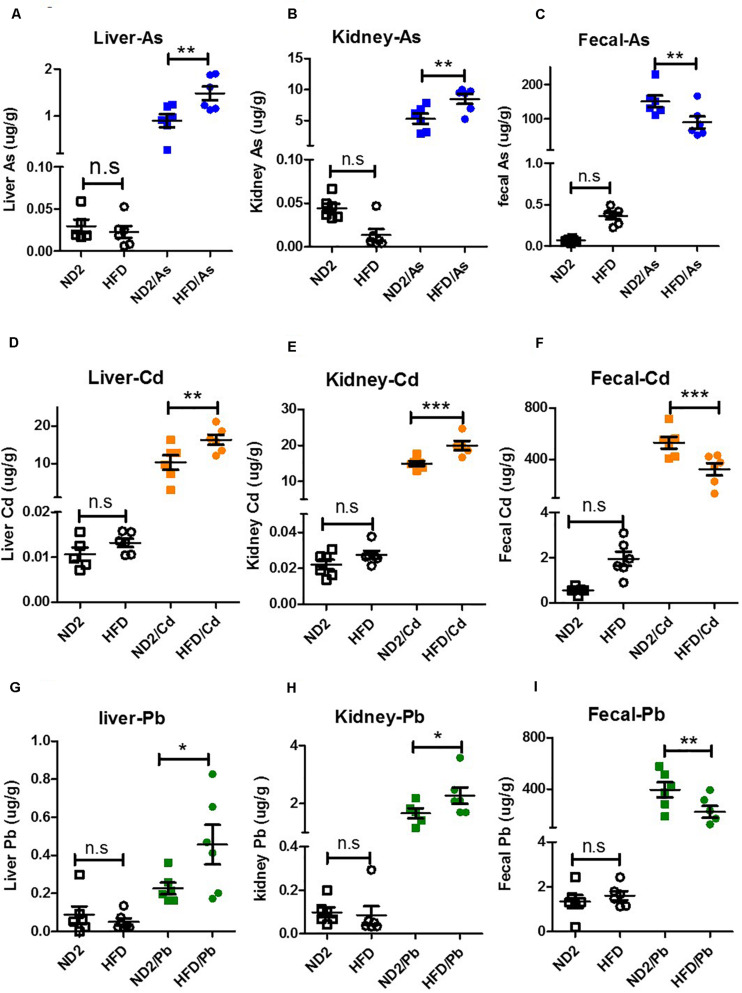
Diet effects on heavy metal accumulation in the liver and kidney and elimination in feces. ND- and HFD-fed mice were exposed to 100 ppm As, Cd, or Pd for 10 weeks (n = 6 for each group). Feces, liver, and kidney were collected for As, Cd, or Pb content analysis. (A,B) Bioaccumulation of As in the liver/kidney of ND- and HFD-fed mice upon As exposure. (C) As content in feces of ND- and HFD-fed mice upon As exposure. (D,E) Bioaccumulation of Cd in the liver/kidney of ND- and HFD-fed mice upon Cd exposure. (F) Cd content in feces of ND- and HFD-fed mice upon Cd exposure. (G,H) Bioaccumulation of Pb in the liver/kidney of ND- and HFD-fed mice upon Pb exposure. (I) Pb content in feces of ND- and HFD-fed mice upon Pb exposure. Data were expressed as mean ± SEM. Statistics according to two-way ANOVAs and Bonferroni post hoc tests. n.s. not significant; *P < 0.05; **P < 0.01; ***P < 0.001.